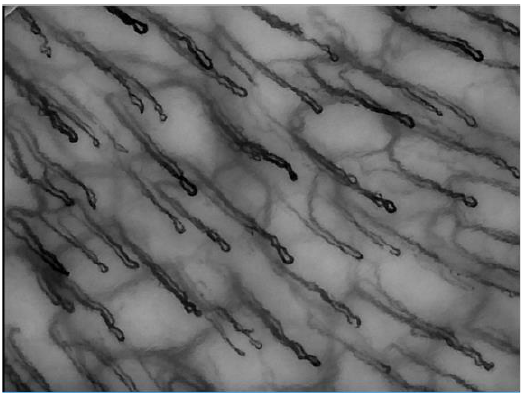
Figure 1. Sample still frame of a typical videocapillaroscopic acquisition (150× magnification). Two vaccines are based on mRNA encapsulated in lipid nanoparticles-BNT162B2 (Pfizer/BioNTech) and mRNA-1273 (Moderna), which code for the viral spike protein (S). Two others — ChAdOx1 nCov-19 (AstraZeneca) and Ad26.COV.2 (Johnson &